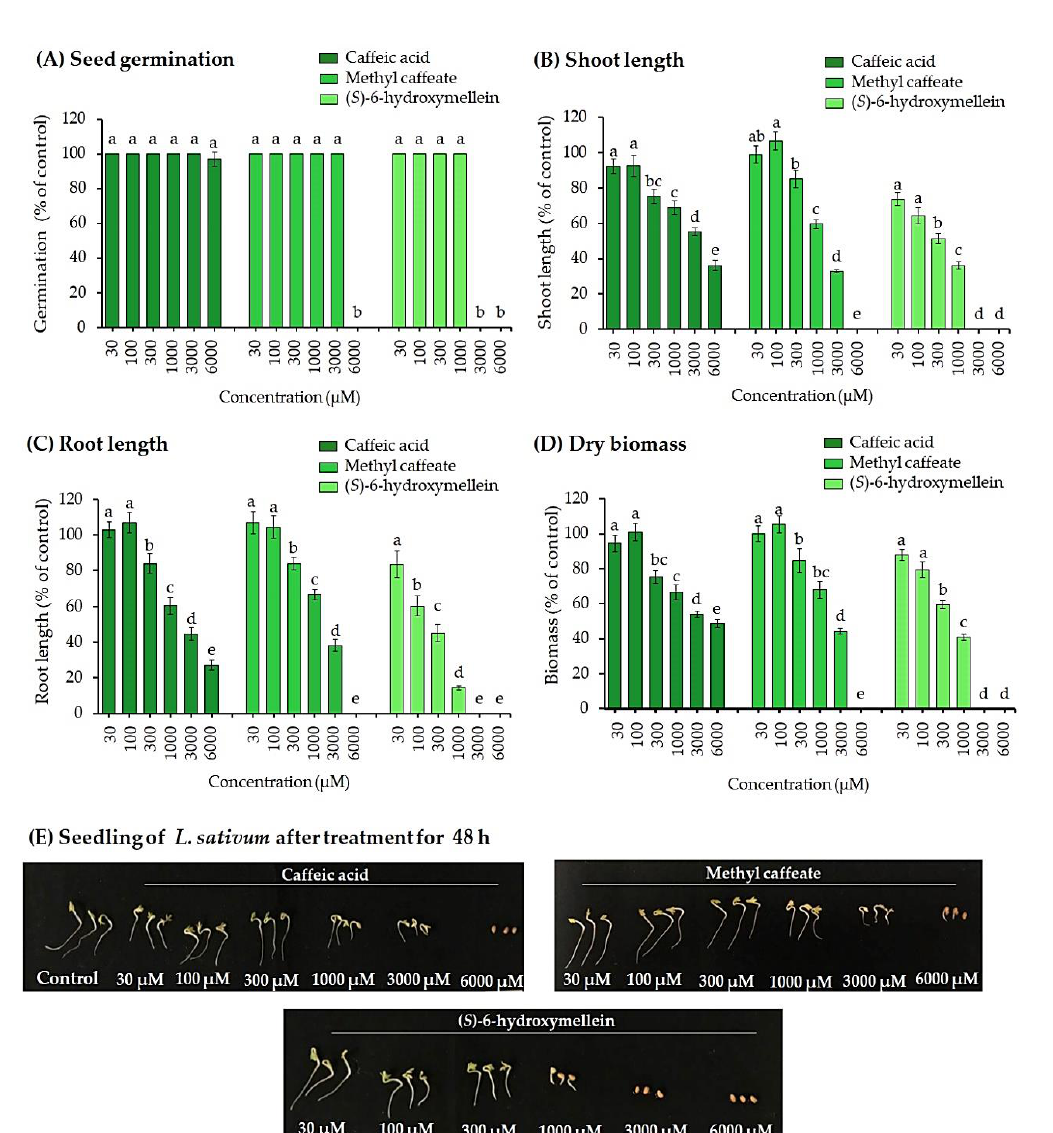
Figure 4. Effects of caffeic acid, methyl caffeate, and ( S )-6-hydroxymellein on L sativum seeds. ( A ) Seed germination, ( B ) shoot length, ( C ) root length, ( D ) dry biomass, and ( E ) seedlings after 48 h of treatment. The values are means ± SD of three replicates ( n = 30); different letters on the bars indicate statistically significant differences (Tukey’s HSD test, p ≤ 0.05).